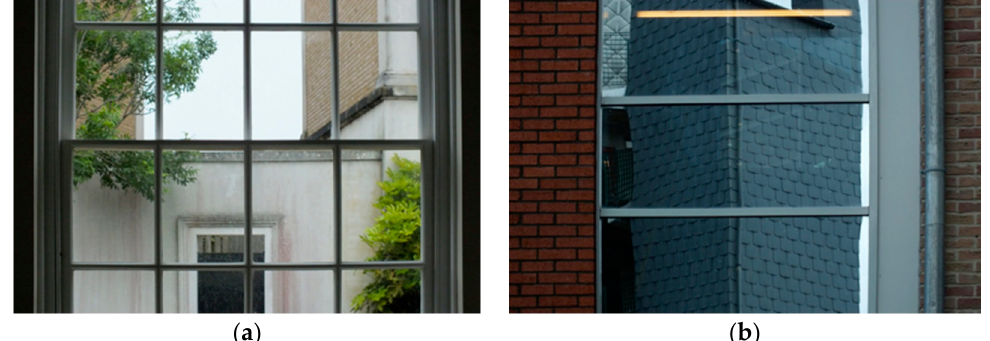
Figure 1. Anne Effkemann: Utopia in Pieces: ( a ) View from a window in Poundbury; ( b ) A fragment of La Mémé mirrored in a